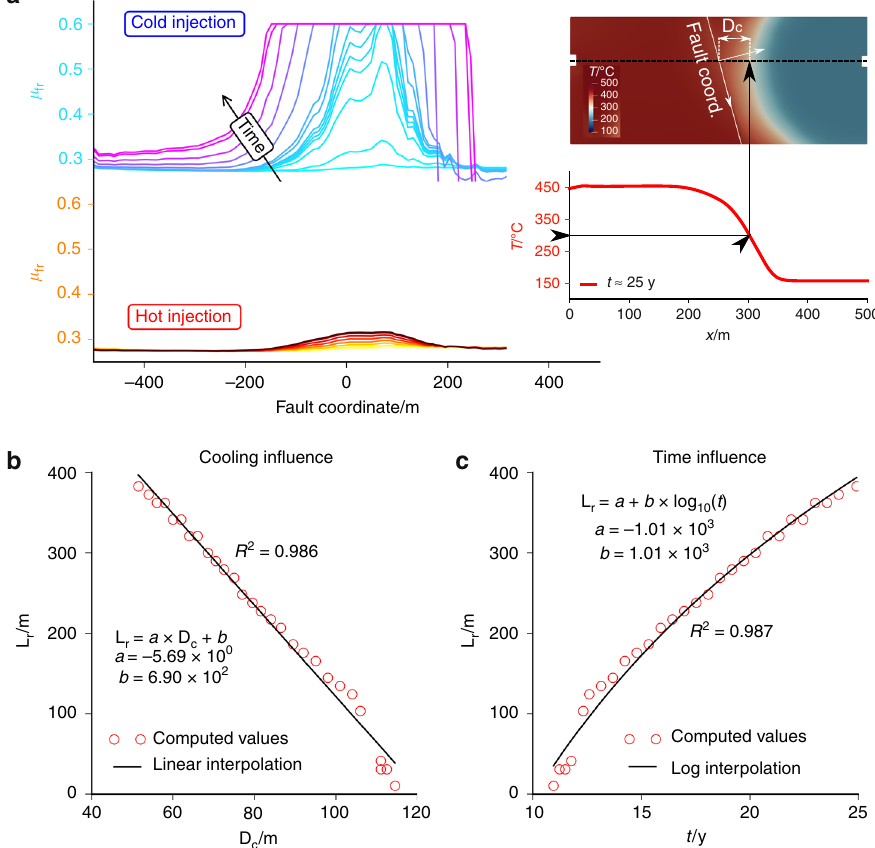
along the fault coordinate for cold water and isothermal injection. b , c The fault fr